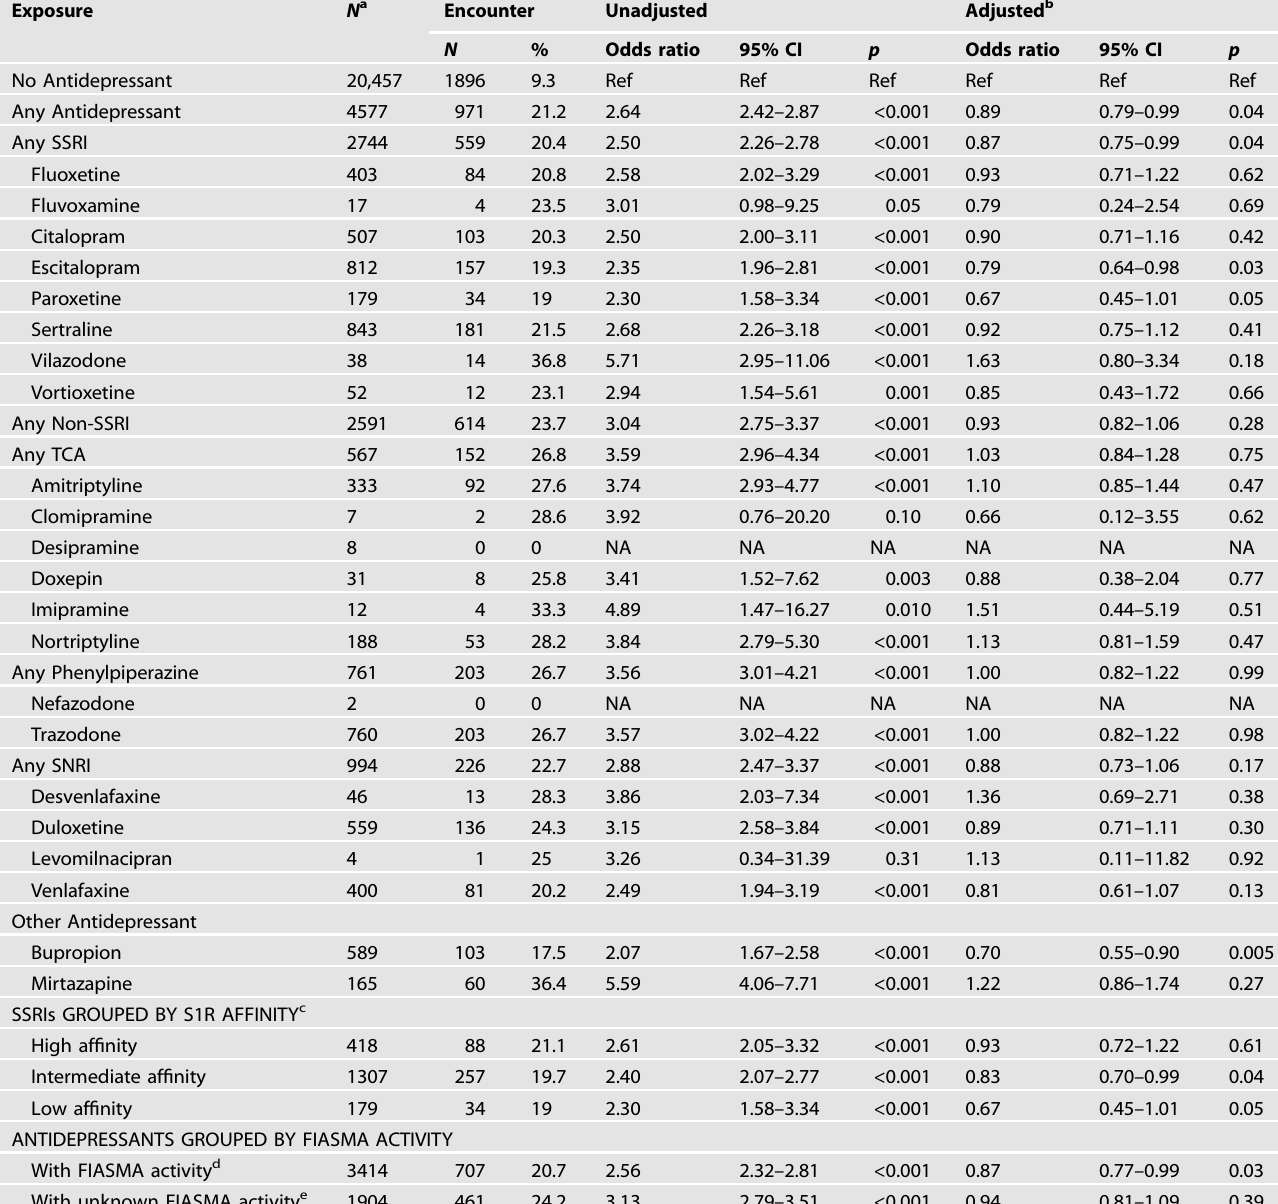
Table 3. Associations between exposure variables and ED or hospital encounter within 30 days.